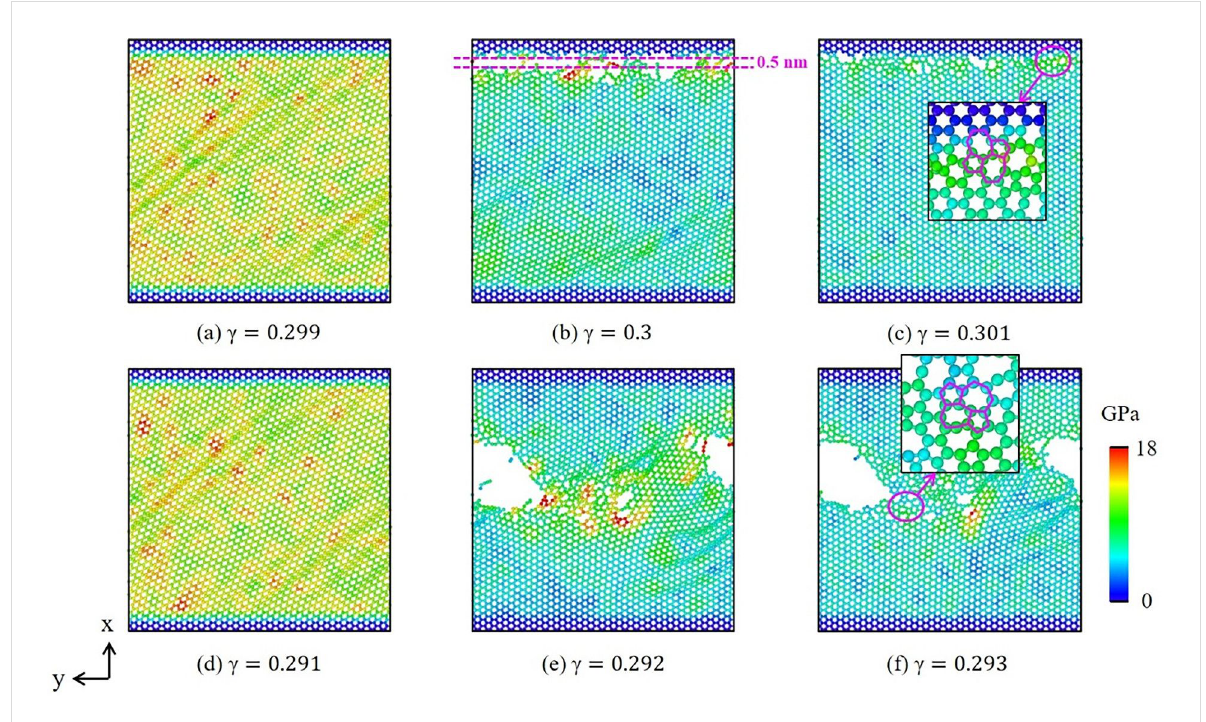
Figure 8: (a–f) Von Mises stress of graphene under shear loading along the armchair direction at 300 K. (a)–(c) Top graphene sheet, (d–f) bottom graphene sheet.